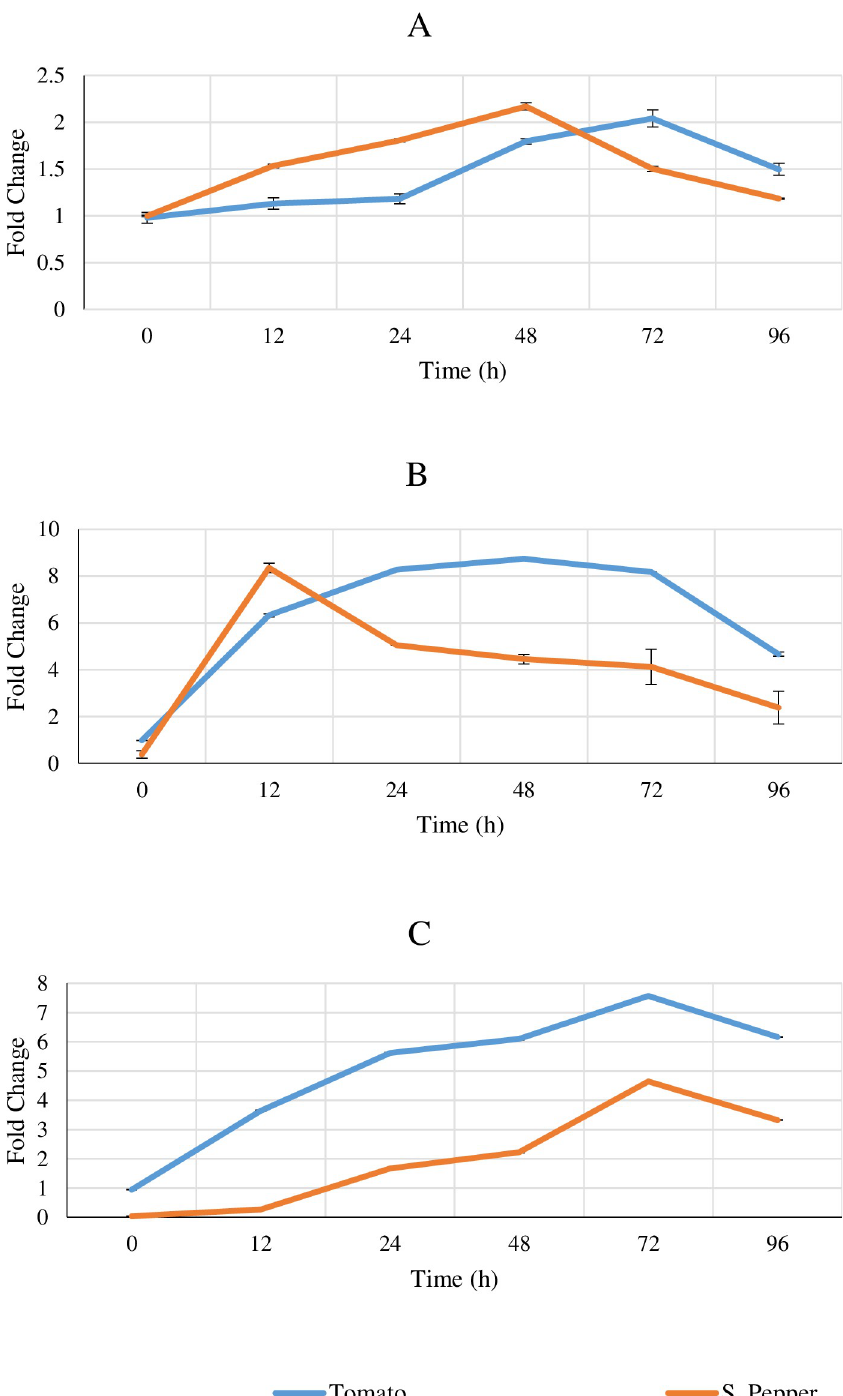
Fig 5. Real-time transcription of defense signalling pathway marker genes following A . nodosum extract application in tomato and sweet pepper plants. Plant tissue was collected at time points (0, 12, 24, 48, 72 & 96h) after seaweed extract application and relative qPCR done to monitor transcripts for (A) PR-1a (B) PinII (C) Etr-1 genes. The data was normalized using the house keeping gene β -actin. Data represents fold change in comparison to the control. The values are averages ± SD for 2 independent trials with 6 replicates. The data was analysed by repeated measures ANOVA at 95% confidence interval to study the effects of time and treatment. The data was also analysed by Student’s t-test to examine the significance of seaweed extract versus control at each time point